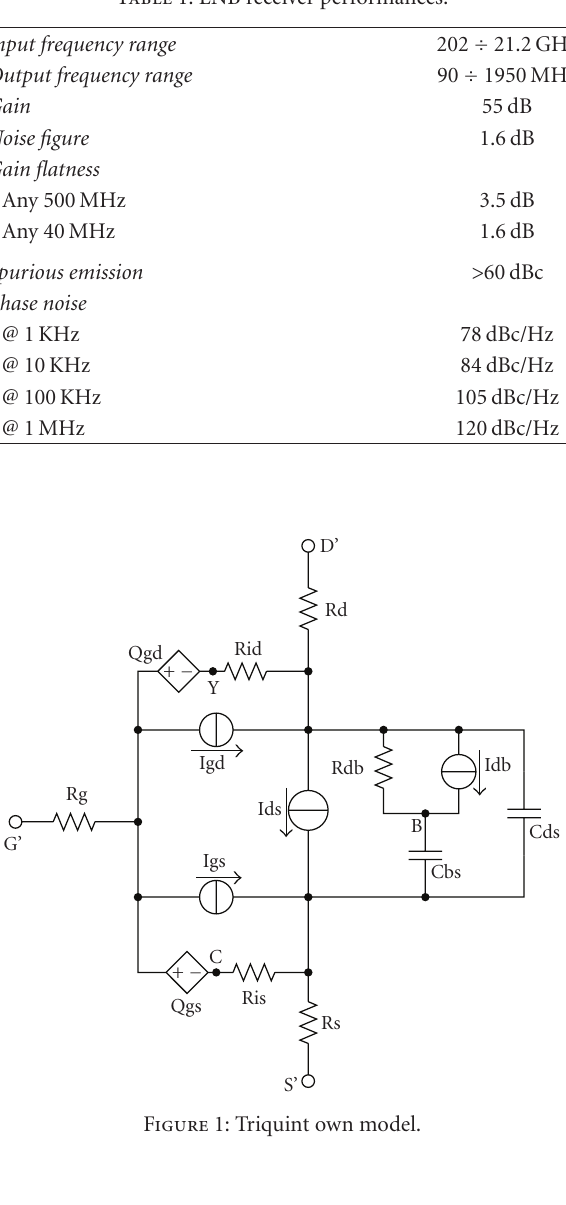
Table 1: LNB receiver performances.